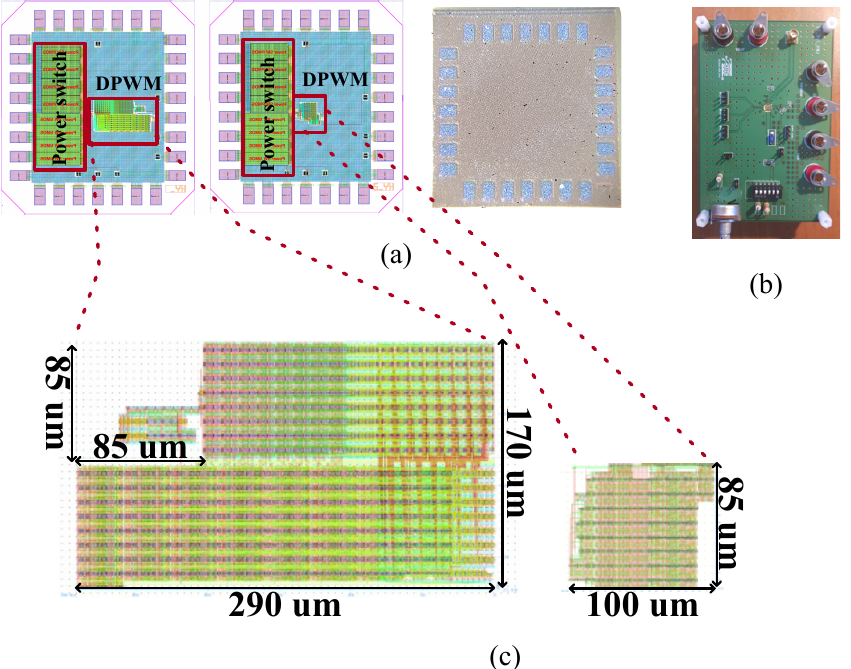
Figure 7. ( a ) Chip layouts and die photo, ( b ) test board, and ( c ) layout of ( left ) the proposed DPWM and ( right ) the conventional DPWM.